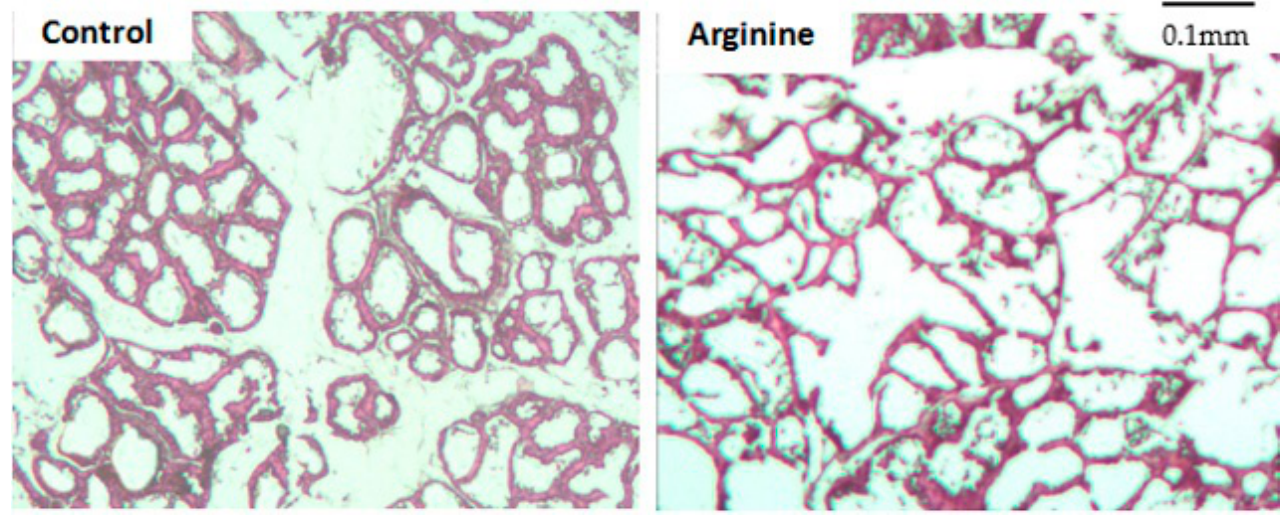
Animals 2021 , 11 , x